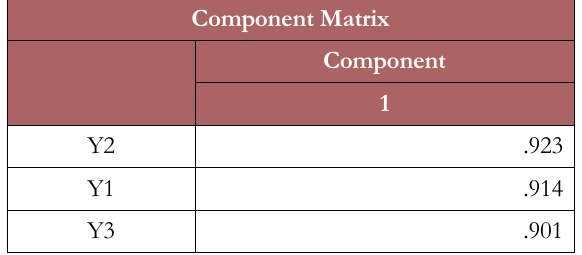
Table 4. Exploratory Factor Analysis for dependent factor